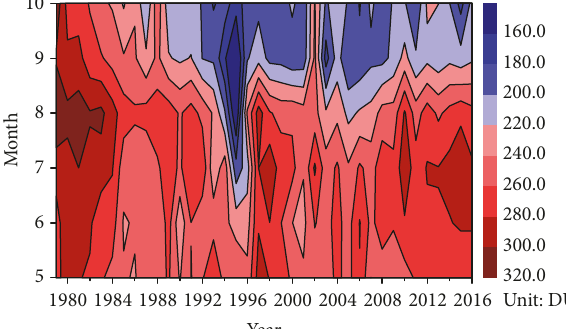
Figure 4: Monthly variation of averaged total column ozone (units: DU) within the polar vortex from 1979 to 2016. The contour interval is 20 DU and the values less than 220 DU (Antarctic ozone hole threshold) are shaded with blue color.